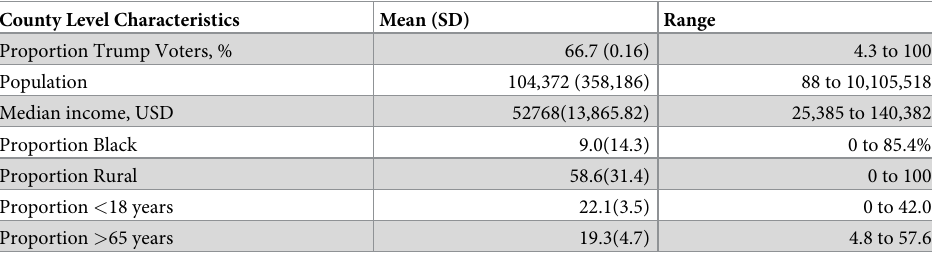
Table 1. Characteristics of the US